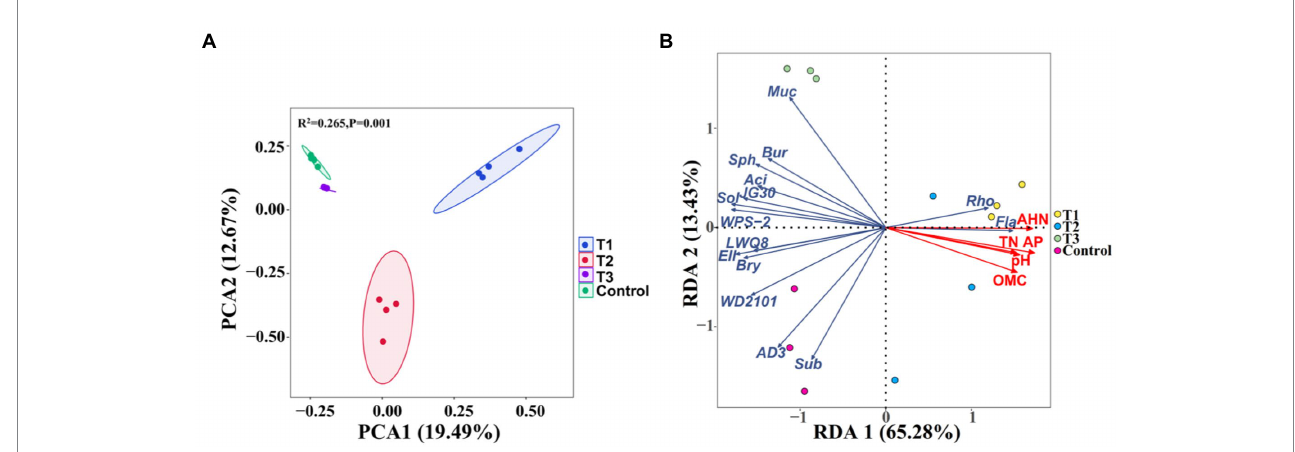
FIGURE 3 Principal component analysis (PCA) of the rhizosphere bacterial communities based on ASVs abundance (A) , and redundancy discriminant analysis (RDA) of the rhizosphere bacterial community compositions at genus levels with soil physicochemical properties (B) . Ellipses have been drawn for each treatment with a confidence limit of 0.95. Sph, Sphingomonas; Bur, Burkholderia; Fla, Flavobacterium; Rho, Rhodanobacter; Muc, Mucilaginibacter; Sol, Solibacter; Sub, Subgroup2; Bry, Bryobacter; Aci, Acidibacter; and Ell, Ellin6067. OMC, organic matter contain; TN, total N; AP, available P; and AHN, alkaline hydrolysis N. Arrows indicate the direction and magnitude of soil physicochemical properties (pH, OMC, total N, AP, and AHN) associated with the different bacterial genus. T1: MF-HZ23 at 3.00 kg/m 2 ; T2: MF-HZ23 at 3.00 kg/m 2 plus CCF at 0.02 kg/m 2 ; T3: CCF at 0.04 kg/m 2 ; and T4: control.